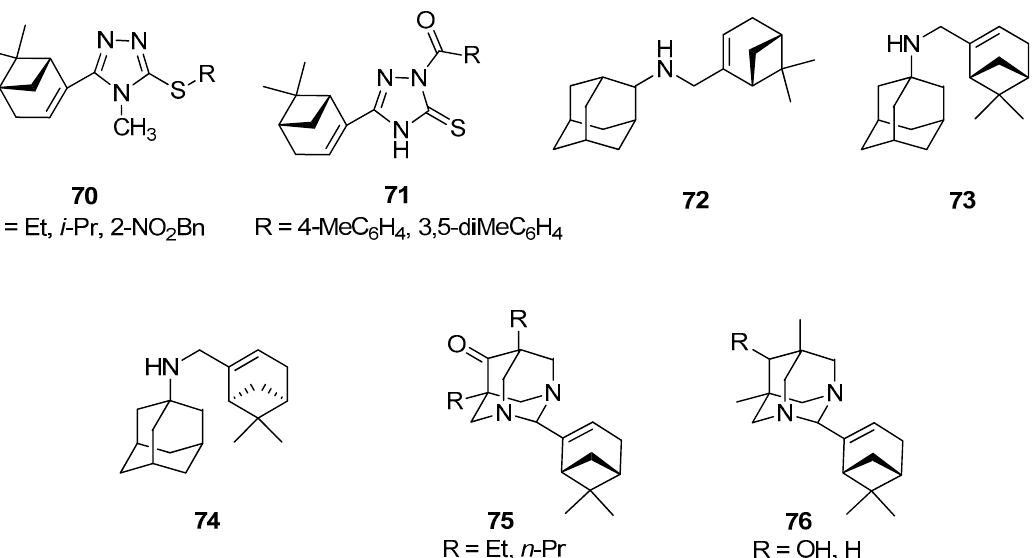
Figure 16. Selected myrtenal’s derivatives with significant antifungal, herbicidal, antiviral, anticancer, and analgesic activities.